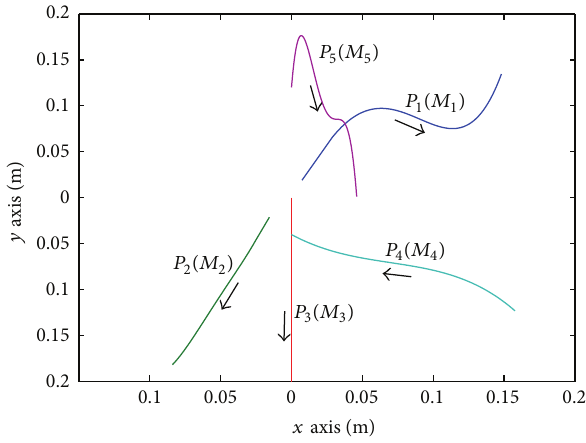
Figure 11: One example of motion path (Algorithm